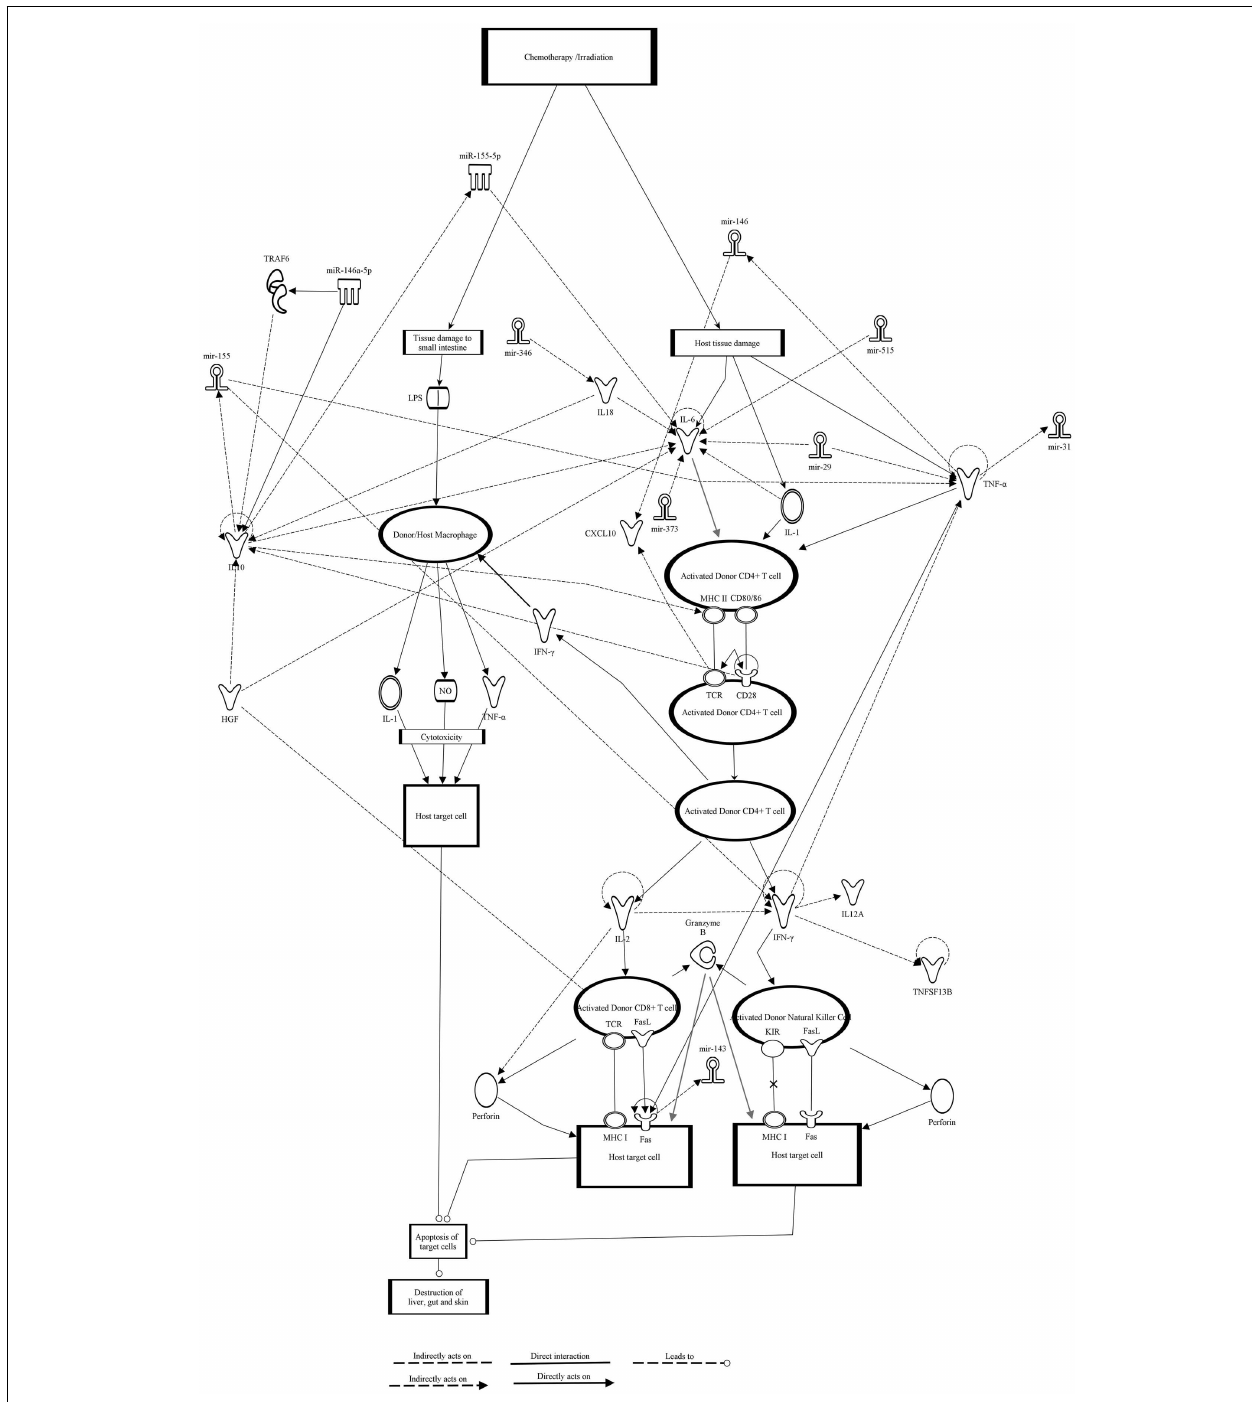
indirect interactions are shown as a dashed line. All the interactions are supported by at least one reference from either the literature or from the information available in the Ingenuity Pathways Knowledge Base.The direction of the interaction is indicated with the arrow head. miR-146a-5p and miR-155-5p are mature miRNAs while miR-515, miR-346, miR-143, miR-373, miR-31, and miR-29 could be primary, precursor or even mature forms of